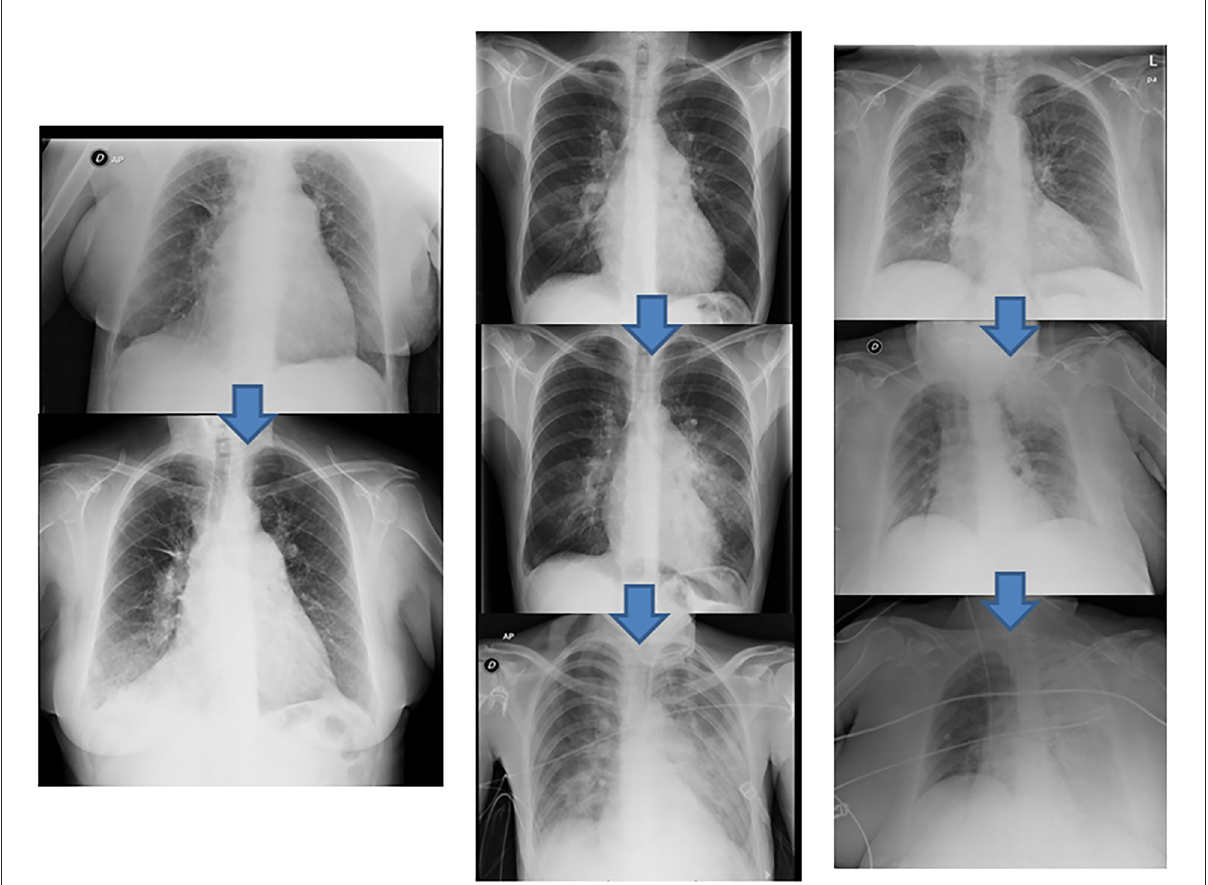
FIGURE6 Radiologic pulmonary injury expression. Examples of different degrees of reperfusion edema according to their radiological expression. (Left) grade 3 reperfusion edema, infiltration in the right lower lobe (above pre-BPA baseline chest radiograph). (Center) grade 4 reperfusion edema, infiltration in the lingula extending to the contralateral lung (above pre-BPA baseline chest radiograph). (Right) grade 5 reperfusion edema, initial infiltration in the left upper lobe that eventually spreads to the entire left lung (above pre-BPA baseline chest radiograph). BPA, balloon pulmonary